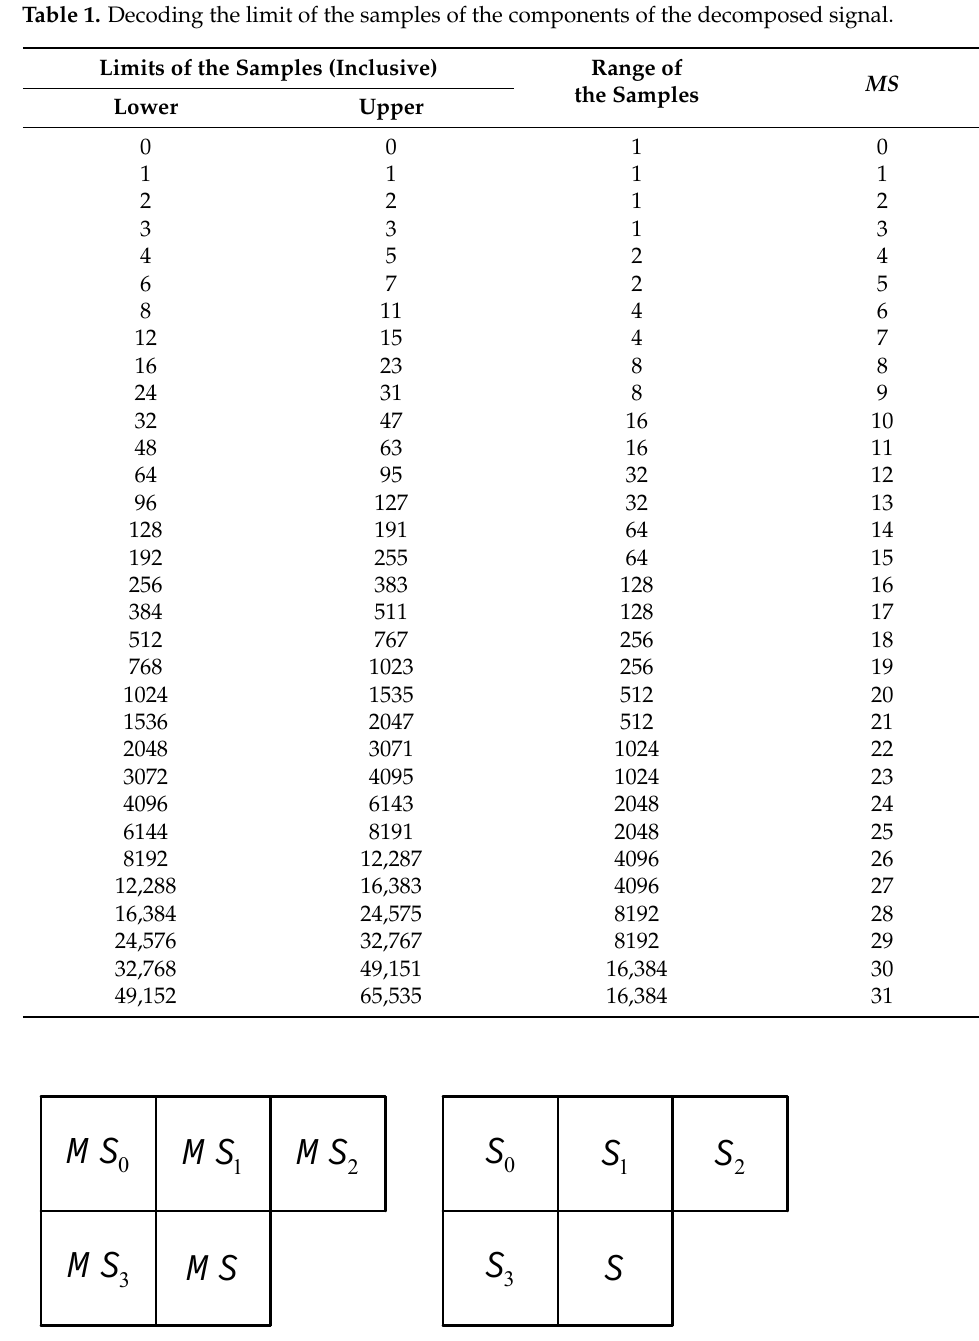
Figure 2. Neighboring magnitude-set indexes MS i and signs S i of already encoded data samples. A flowchart of the entropy decoder and the decoding probability estimator, based on single-pass adaptive histograms with fast adaptation, is shown in Figure 3. The adaptation process starts from a uniform distribution and requires several data samples to complete. The adaptation time is proportional to the number of histogram bins and the difference between the uniform distribution and the exact distribution of the variable being